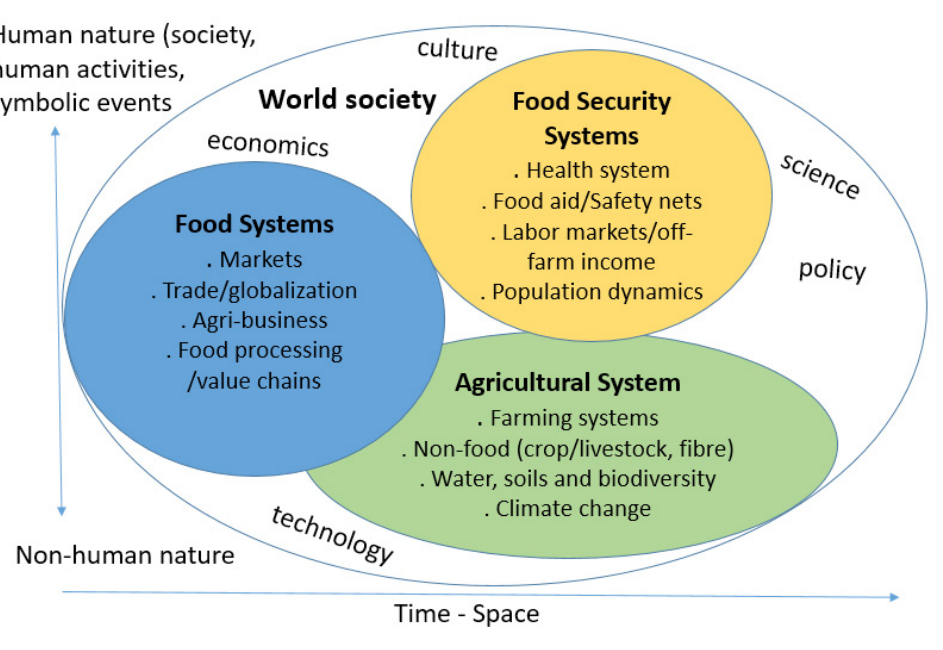
Figure 1: The three main sub-systems –i.e. Agriculture, Food and Food security- which are defining food and agriculture systems embedded in society- or short Food and Agriculture System in Society or FASS (adapted from Stephens, Jones, et al. 2017). This framework 1 describes the large objects. “Society” here includes material/bio-physical